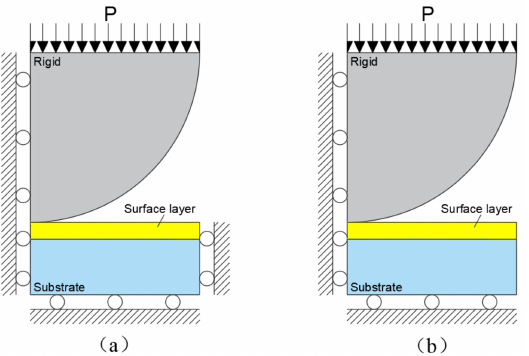
Figure A2. Finite element model with different boundary condition on the outer surface. ( a ) Roller boundary condition. ( b ) Free the outer surface.